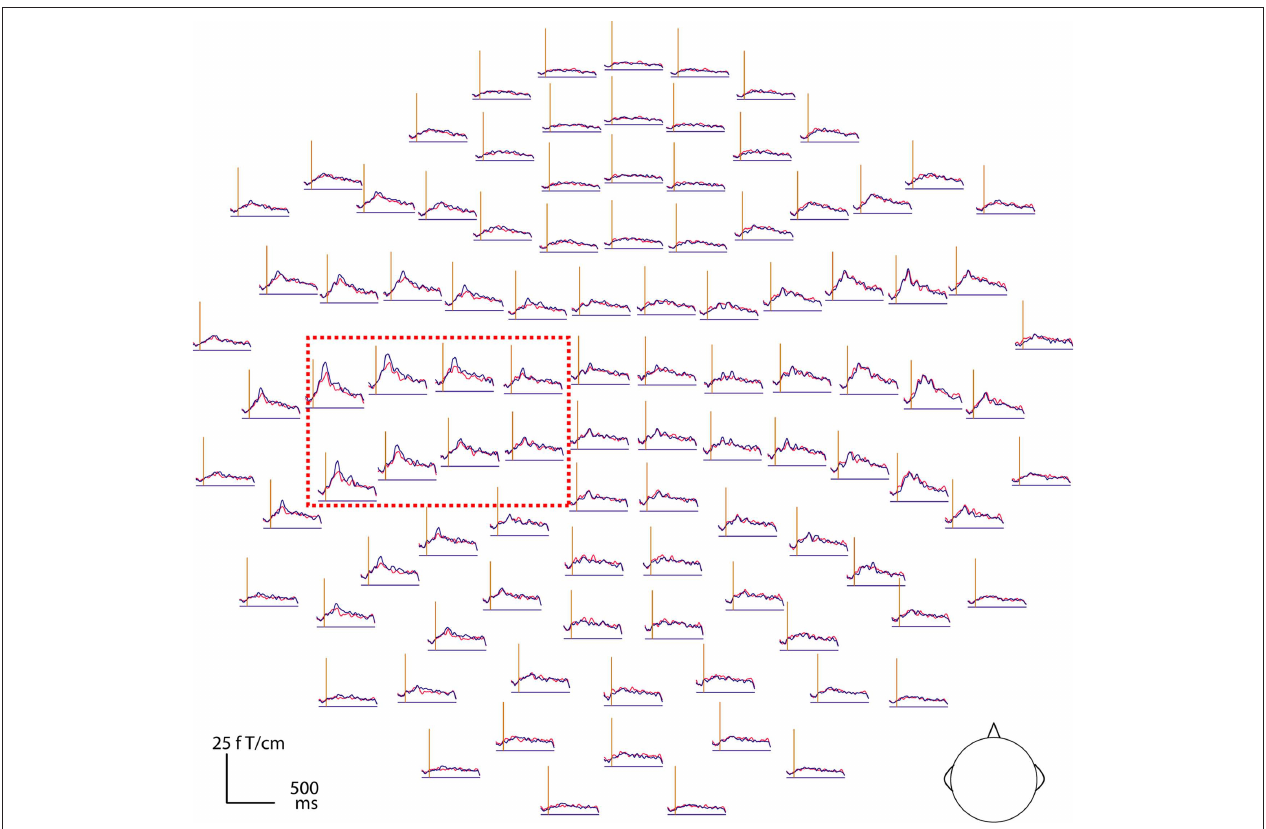
FIGURE 4 | Magnetic brain responses to deviant words (in red) and deviant pseudowords (blue) in the Attend condition after subtraction of the respective standard response. The curves plot the local gradient vector amplitudes of the magnetic MMN (DEV minus STD responses) for 102 recording